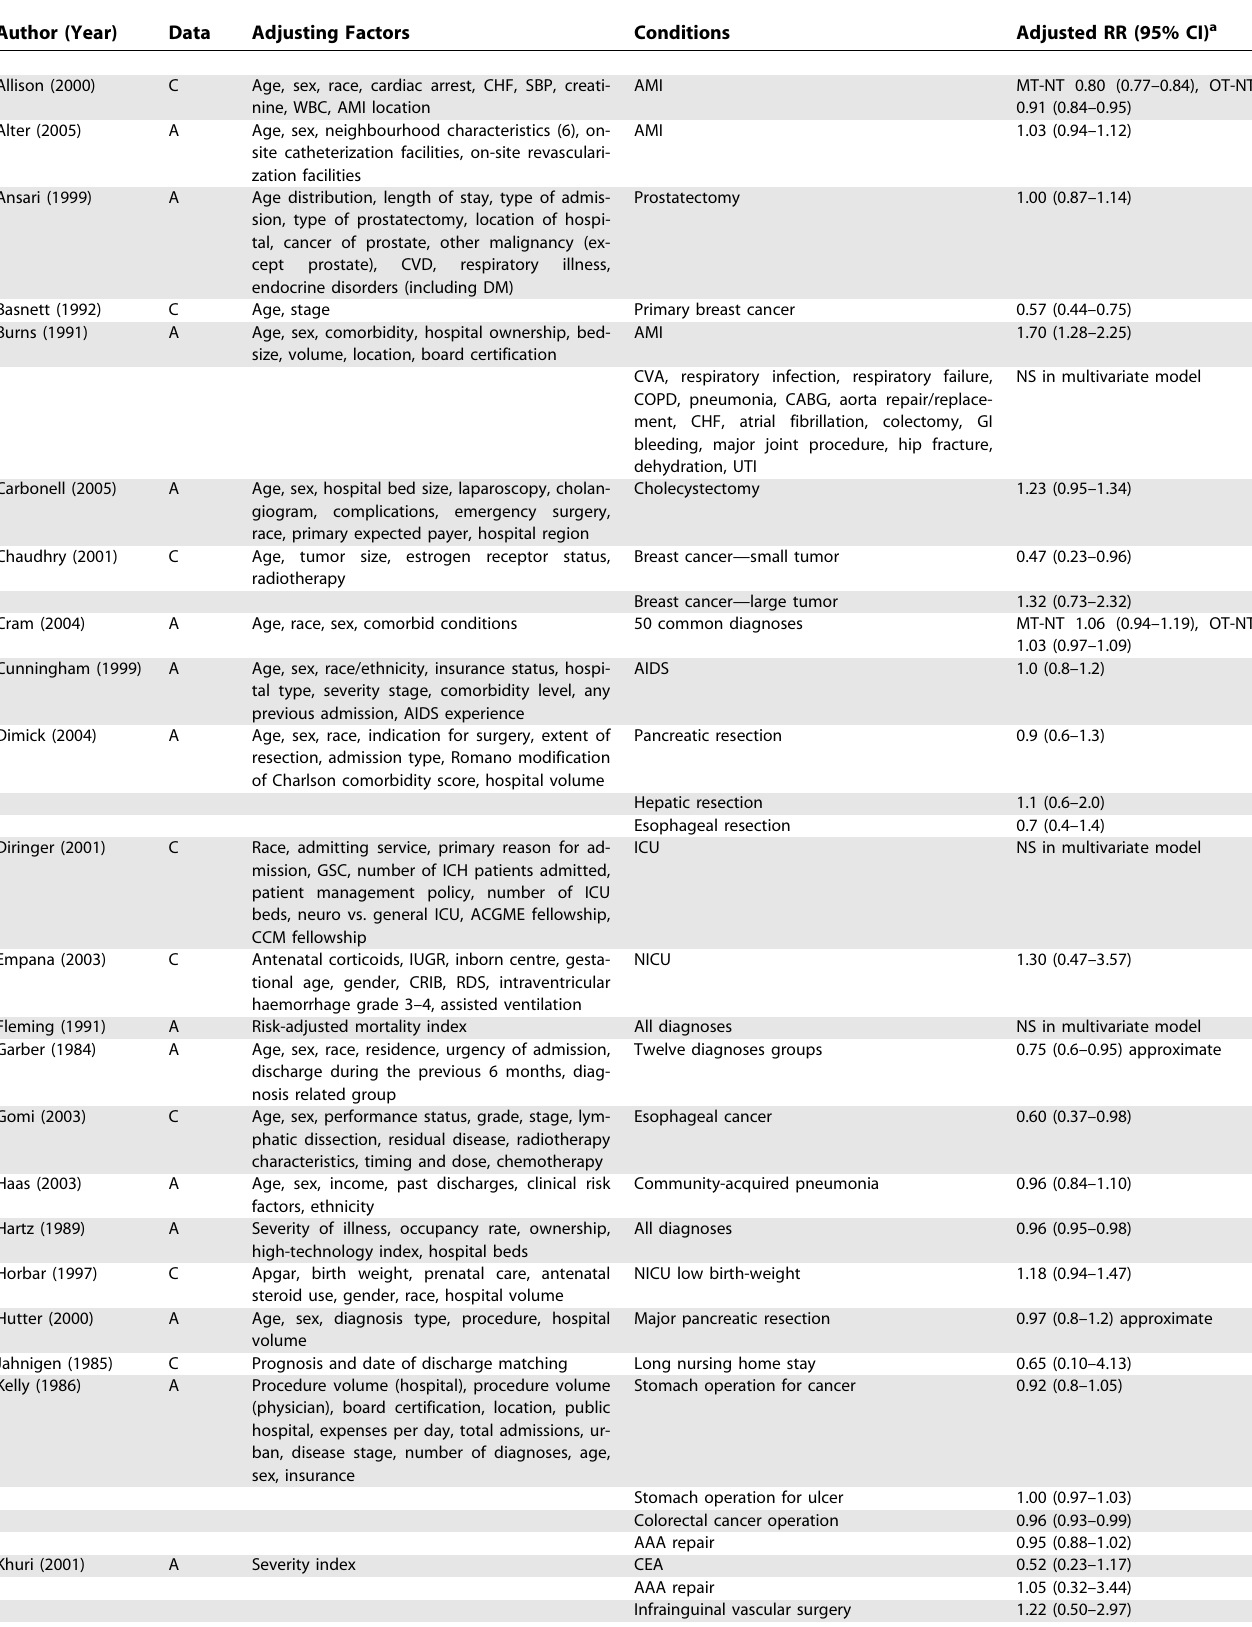
Table 2. Comparisons of Teaching versus Nonteaching Healthcare on Patient Mortality Author